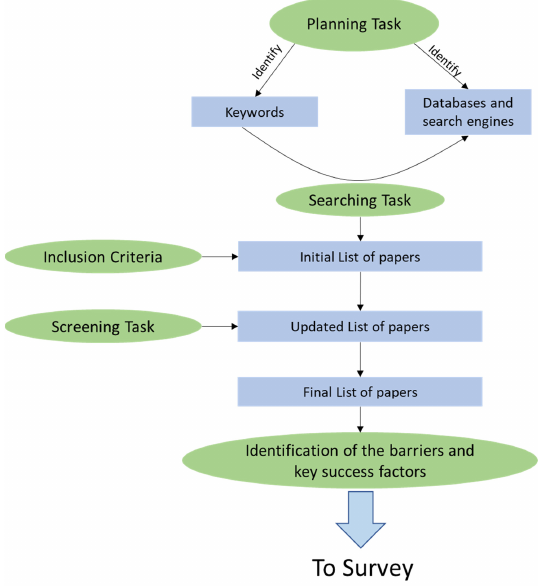
Figure A2. Literature review process followed in the current study.